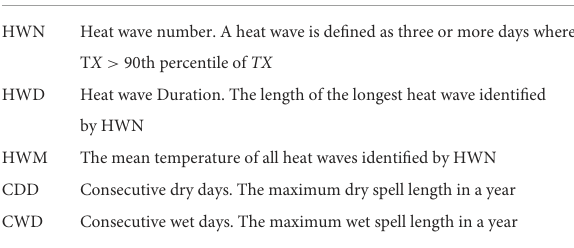
TABLE 1 Health sector-related climate indices